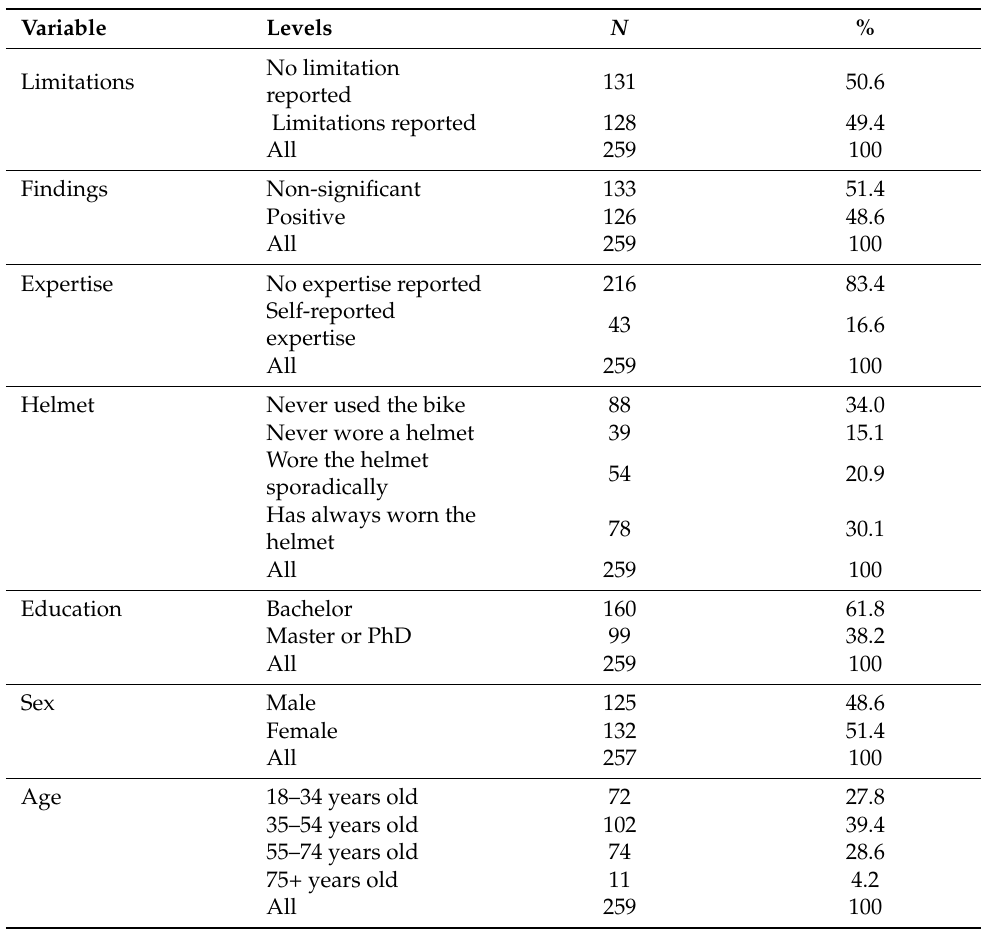
Table 1. Sample characteristics.